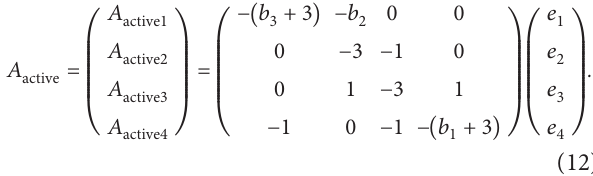
approach with small modifications, the synchronization between two hyperjerk systems (2) with different pa- rameters can also be considered.